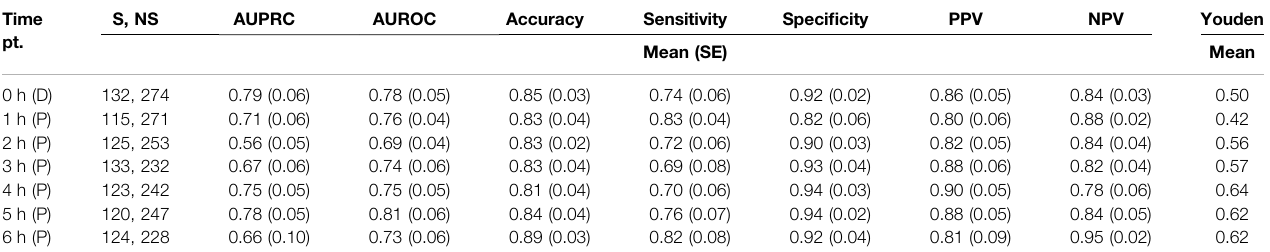
TABLE 2 | Performance of the proposed model predicting the presence of shock/non-shock using automated CPD and heart rate. The time pt. column depicts the subsequent hours from the time of taking the observation, at which the results were recorded. The unequal number of shock and non-shock sequences is due to the absence of patient data with the increasing number of hours. (S/NS, number of shock/non-shock sequences present; AUPRC, area under precision-recall curve; AUROC, area under receiver operating characteristics; PPV, positive predictive value; NPV, negative predictive value; D, detection; P, prediction). Time pt.